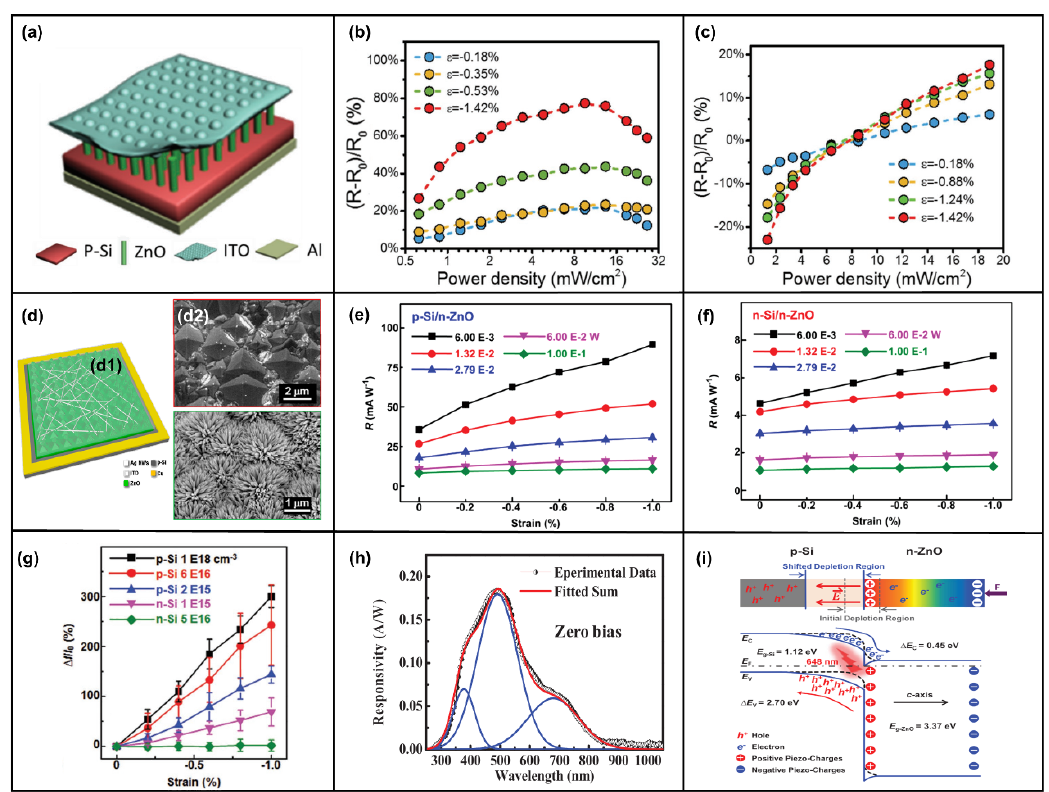
Figure 5. Device structure and characterization of Si/ZnO photodetector. ( a ) Device structure of p-Si/n-ZnO NWs photodetectors. ( b , c ) Relative changes of photoresponsivity of the device under different strains and illumination of 442 nm and 1060 nm at − 2 V, respectively. Reproduced with permission from [159]. Copyright (2017) Advanced Materials . ( d ) Schematic structure of a p-Si/n-ZnO NW hybridized photodetector etched by KOH. Reproduced with permission from [160]. Copyright (2014) American Chemistry Society Nano . ( e , f ) The photoresponsivity as a function of compressive strain under different optical powers for the p-Si/n- ZnO NWs (at −1 V) and the n -Si/n-ZnO NWs (at 1 V) heterojunction photodetectors. Reproduced with permission from [161]. Copyright (2018) Advanced Functional Materials . ( g ) The average relative changes in photocurrent as a function of external compressive strain under 1.90×10 − 3 W laser power for the Si/ZnO heterojunction photodetectors with different doping types and concentrations of Si. Reproduced with permission from [162]. Copyright (2020) Advanced Functional Materials . ( h ) Deconvoluted spectral responsivity at zero bias (0 V). Reproduced with permission from [164]. Copyright (2017) Journal of Physics D-Applied Physics. ( i ) Schematic energy band diagrams of the p-Si/n-ZnO NWs without (dashed black line) and with (solid blue line) external compressive strain to 648 nm laser illumination. Reproduced with permis-